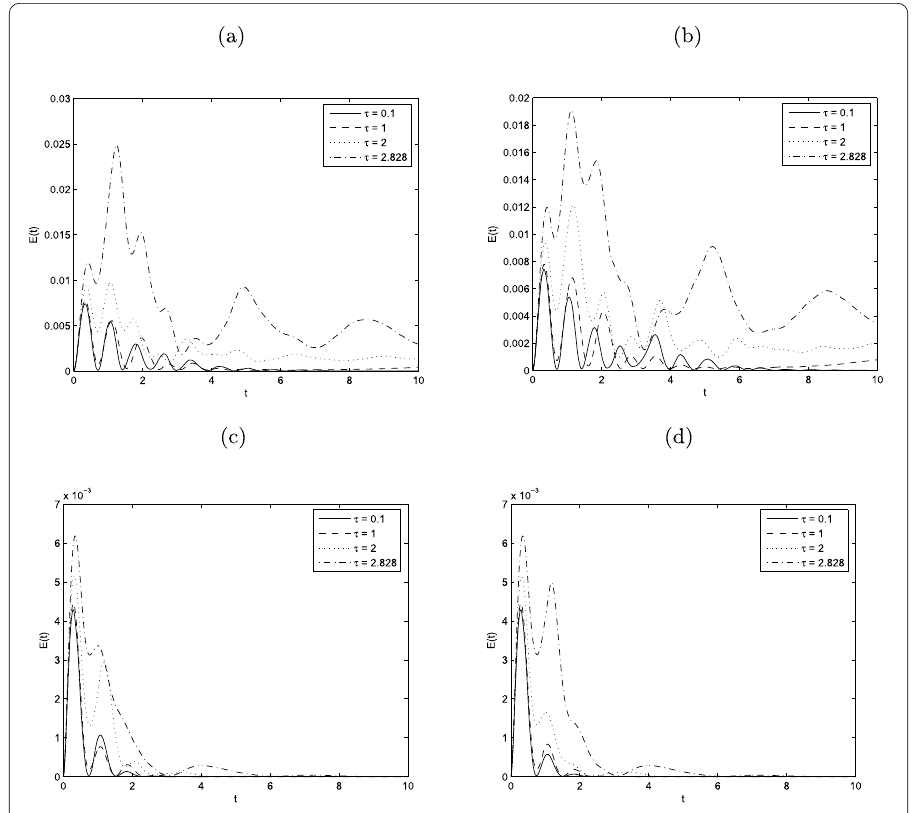
Figure 8 The energy E 0 ( t ) of the wave system (1.6)-(1.10) with: a) various delays when a ( x ) = 1 and for k = –0.2; b) different delays when a ( x ) = 1 and for k = 0.2; c) several delays when a ( x ) = 3 and for k = –0.2; d) various delays when a ( x ) = 3 and for k =